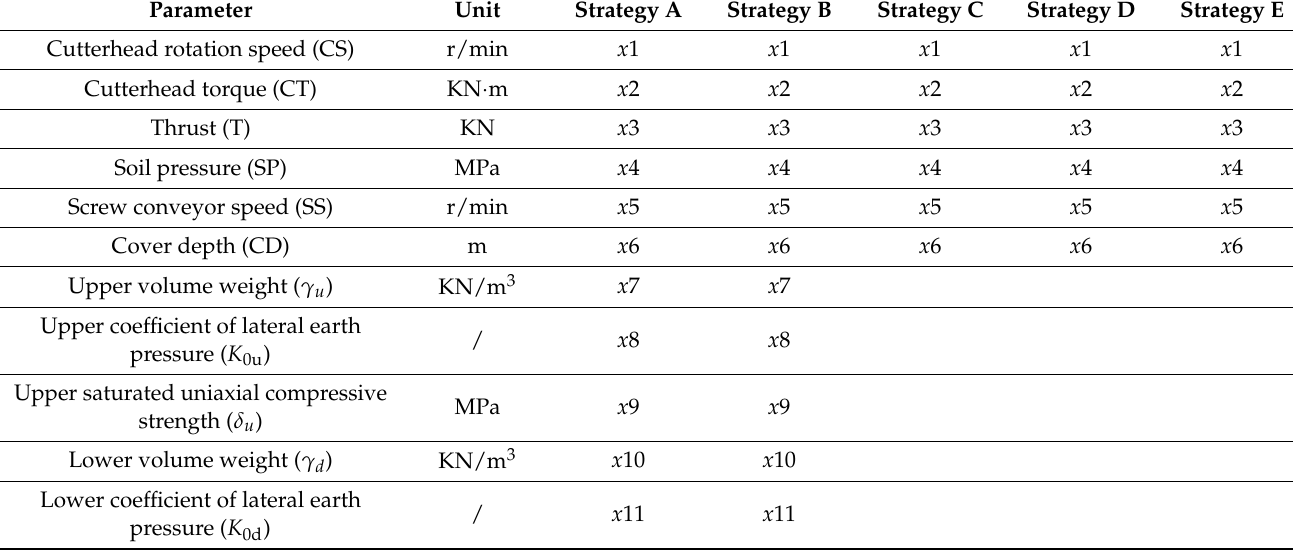
Table 1. Input and output parameters of each